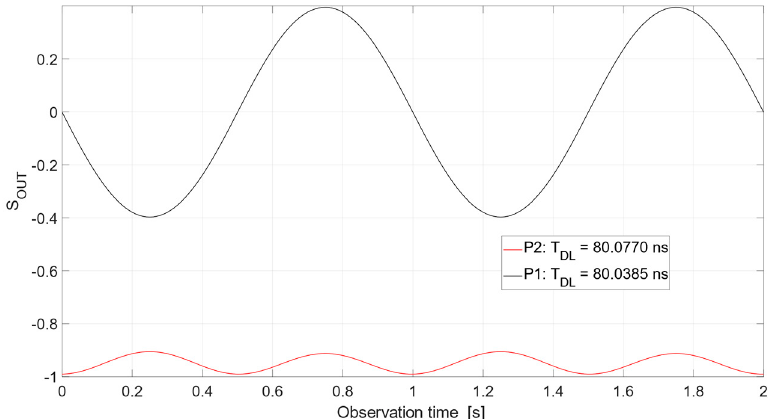
Figure 5. Illustration for the conversion of harmonic movement of an object to the output signal of the microwave correlation detector.